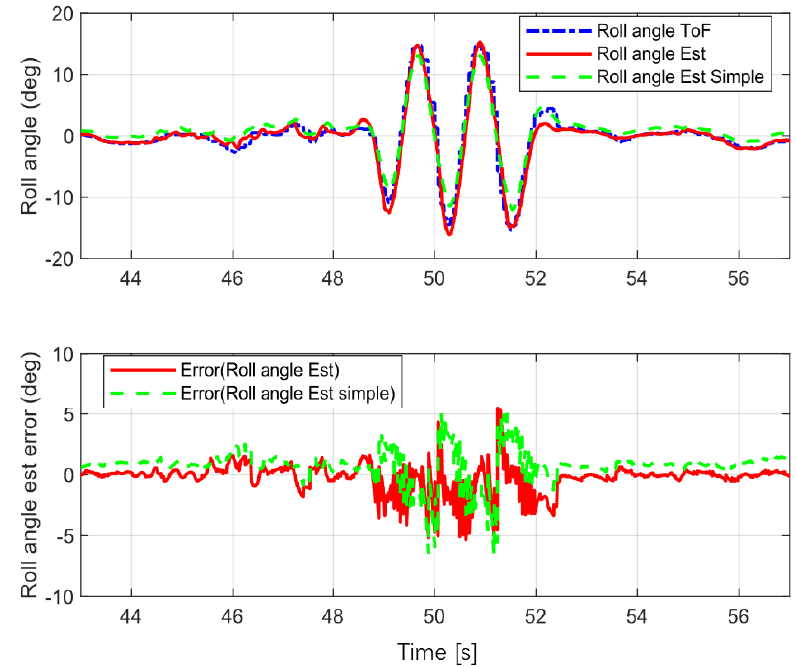
Figure 9. Sine wave turning.